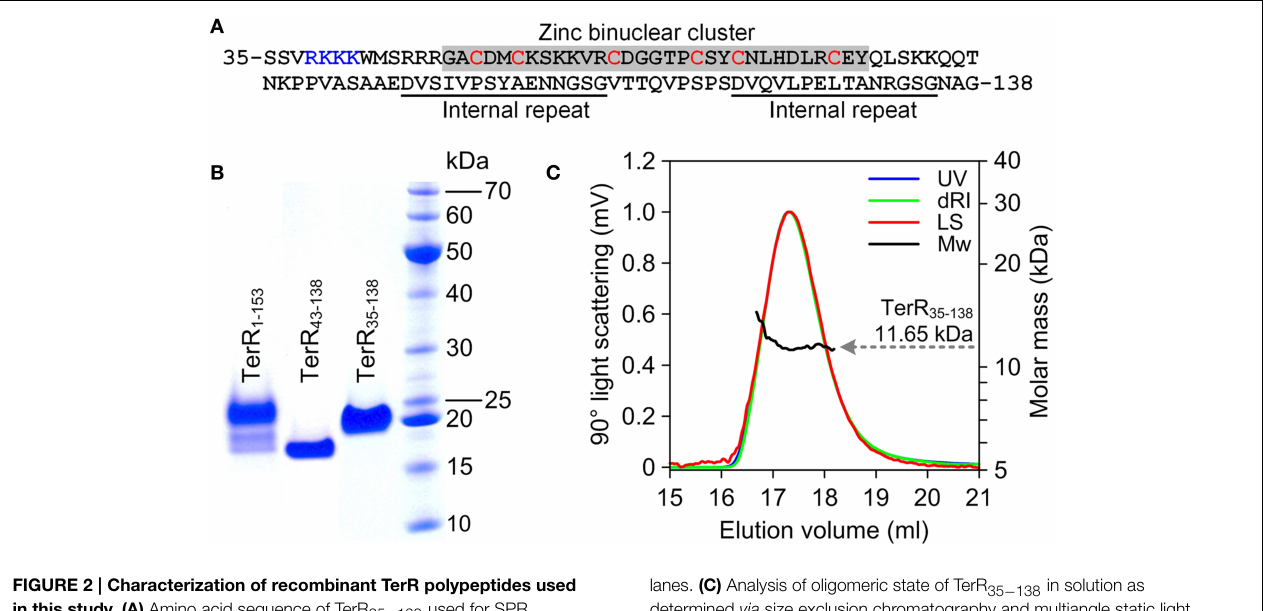
FIGURE 2 | Characterization of recombinant TerR polypeptides used in this study. (A) Amino acid sequence of TerR 35 − 138 used for SPR interaction analysis with specific DNA fragments. The N -terminal basic stretch at positions 38 to 47 and the zinc cluster region are highlighted. (B) SDS-PAGE analysis of purified TerR fragments as indicated at the specific